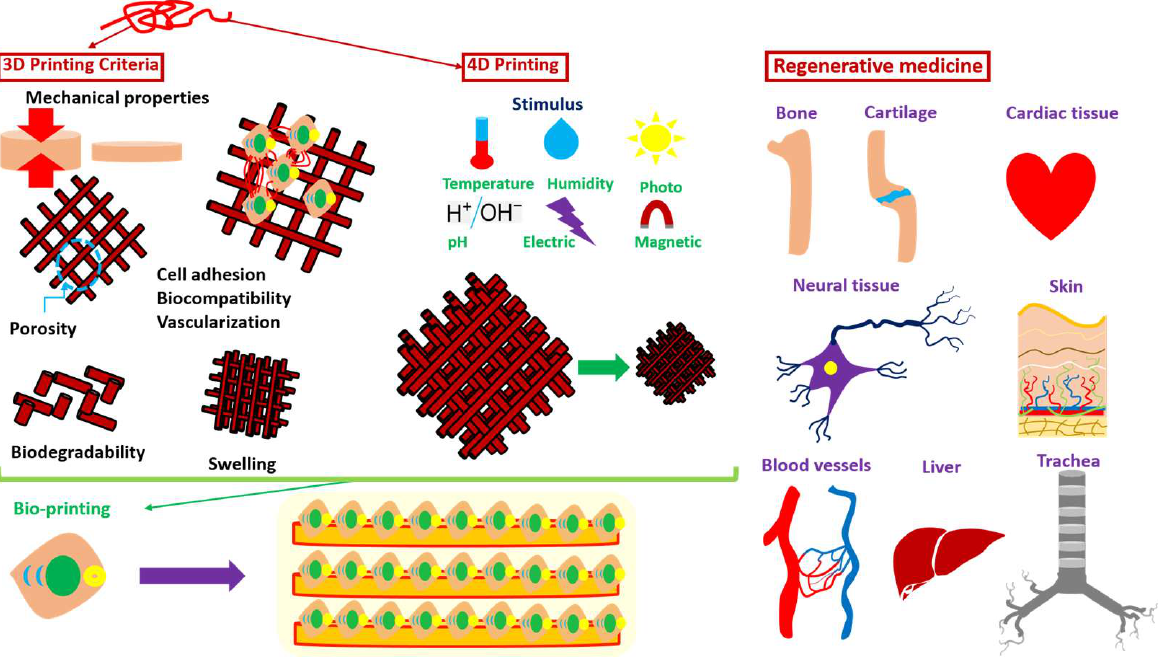
Figure 2. Schematic illustration of the criteria that should be considered for tissue engineering, differences of 3D Vs 4D (bio)-printing and main organs/tissues in regenerative medicine currently under investigation.